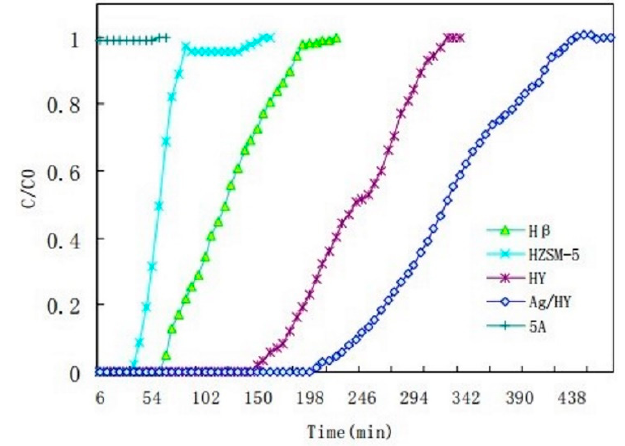
Figure 11. The breakthrough curves of toluene on different zeolites (flow rate: 300 mL/min and toluene inlet concentration: 100 ppm). Reprinted from Reference [89], with permission from RCS publishing. Table 1. Specific surface area, pore diameter, and adsorption capacity of different zeolite A [54]. Zeolite Specific Surface Area (m 2 /g) Pore Diameter (Å)